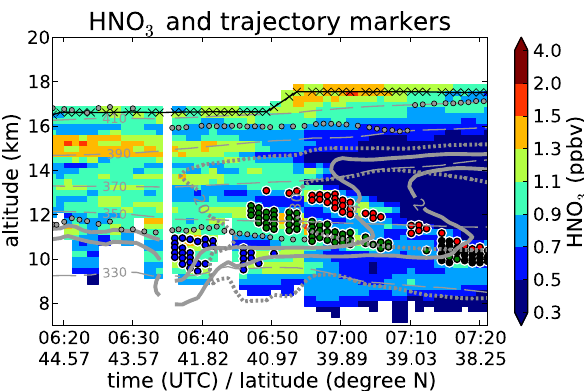
Fig. 6. Western cross section of HNO 3 including markers of se- lected air parcels. The red, green, blue and black circles mark the position of air parcels examined in the backward-trajectory simula-